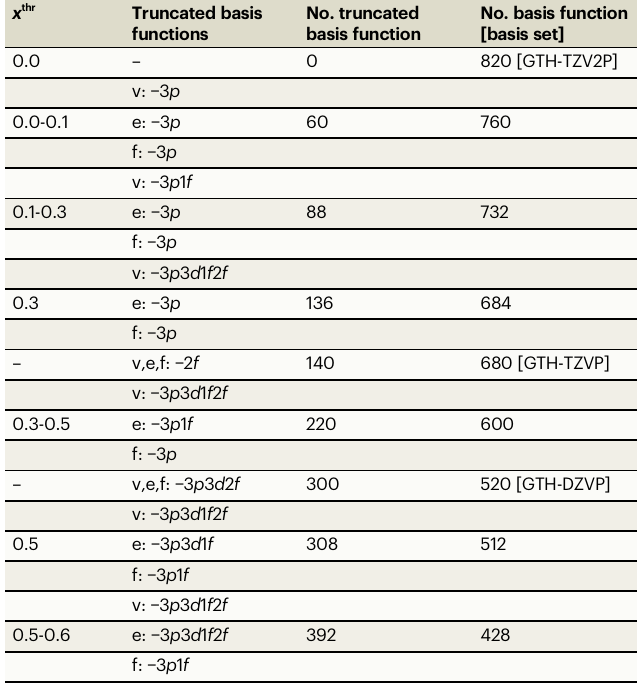
Due totheT d symmetryofthe system,wecan categorize Ag atoms into 3 groups: vertex (4atoms), edge(12 atoms), and face (4atoms), withthe notation “ v ” , “ e ” , and “ f ” , respectively.